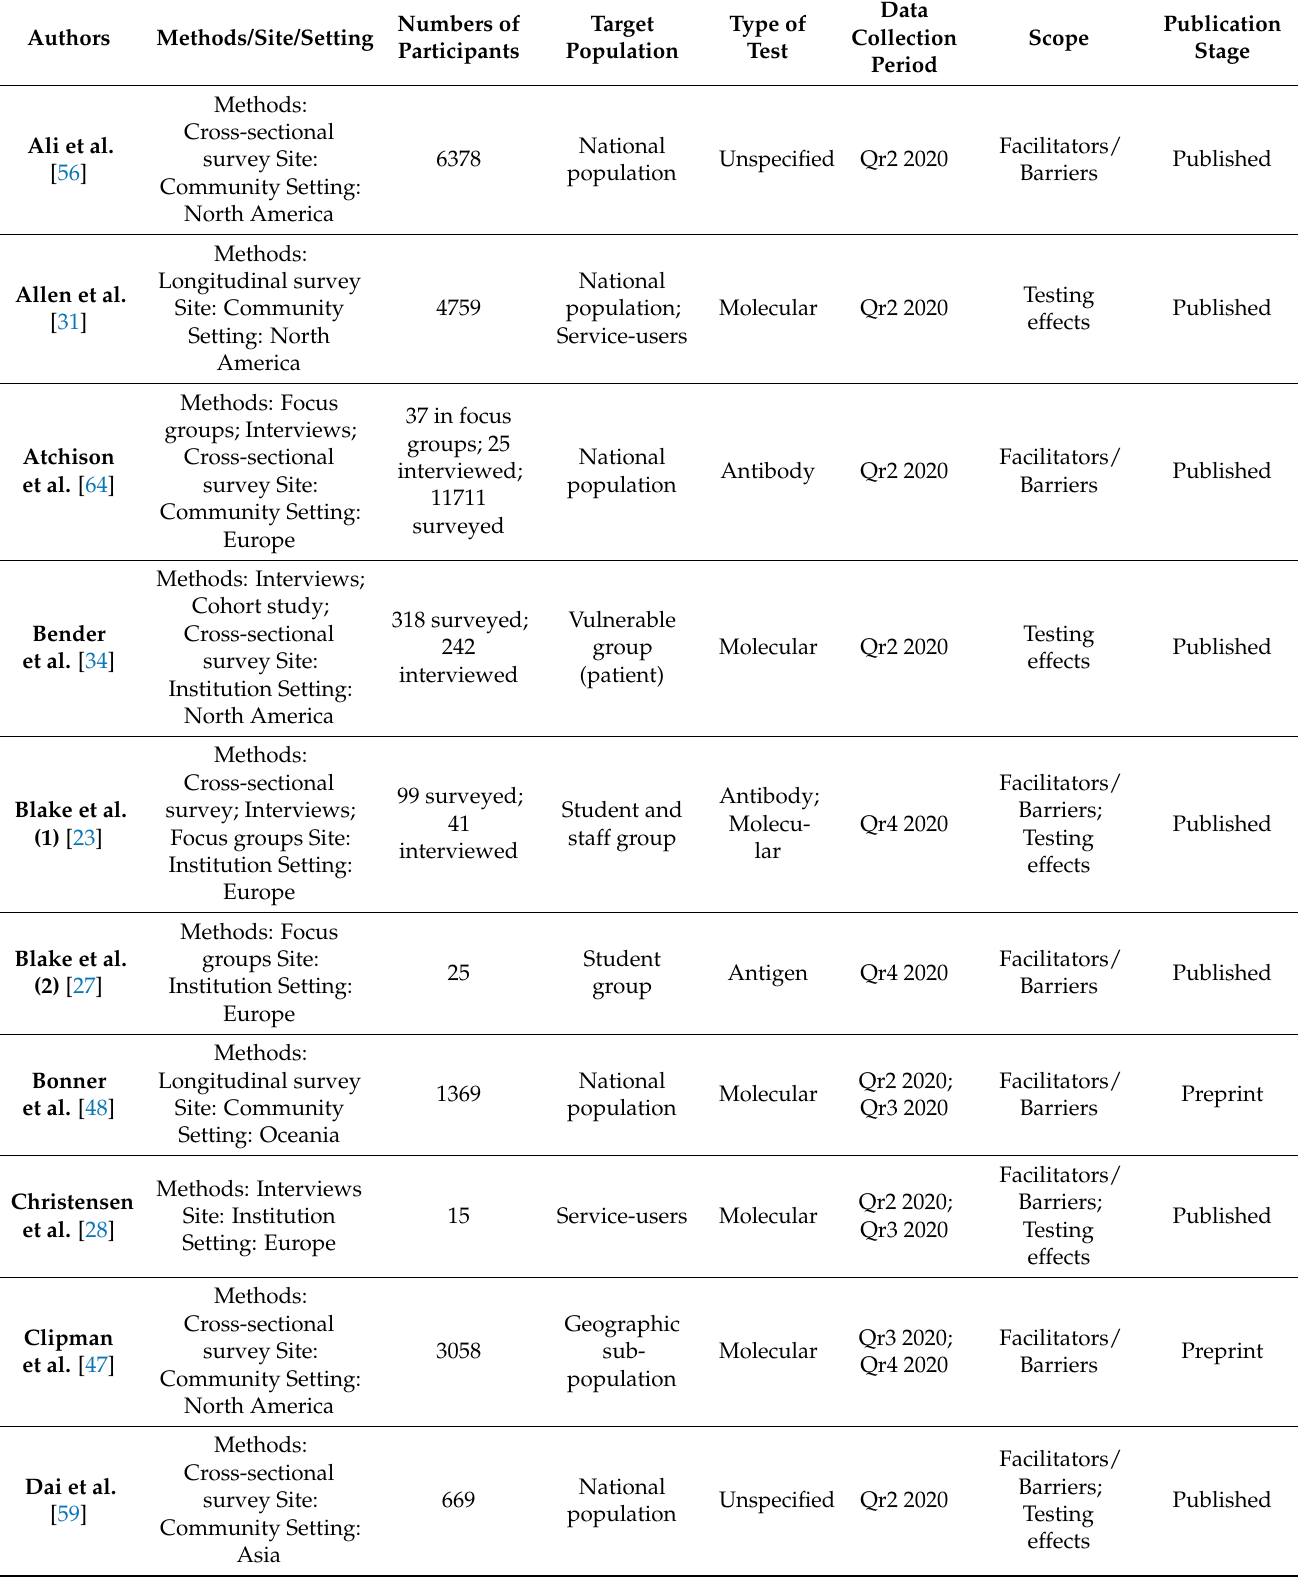
Table 1. Characteristics of included